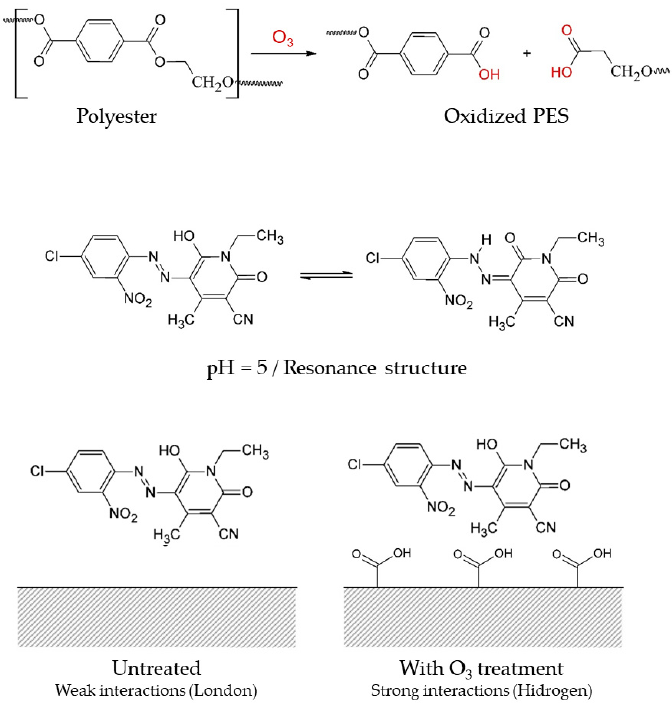
Figure 2. Dyeing mechanism of the C.I. Disperse Yellow 211 dye and polyester fibers.